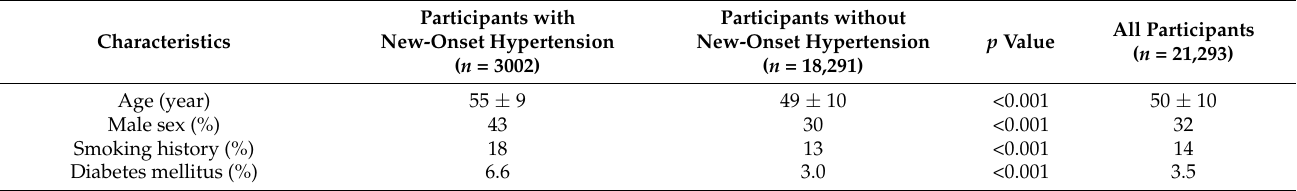
Table 2. Comparisons of baseline characteristics in the traditional definition population (hypertension was defined as systolic blood pressure ≥ 140 mmHg or diastolic blood pressure ≥ 90